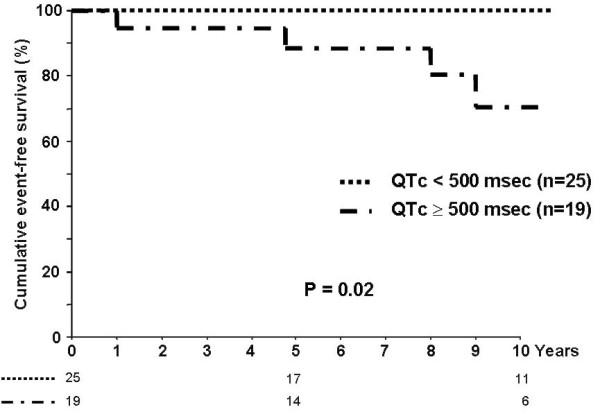
Kaplan-Meier curves of event-free survival and survival according to QTc interval after left cardiac sympathetic denervation in patients with only syncope, or aborted cardiac arrest before left cardiac sympathetic denervation. (Modified from ref. [65] with permission from Lippincott Williams and Wilkins).